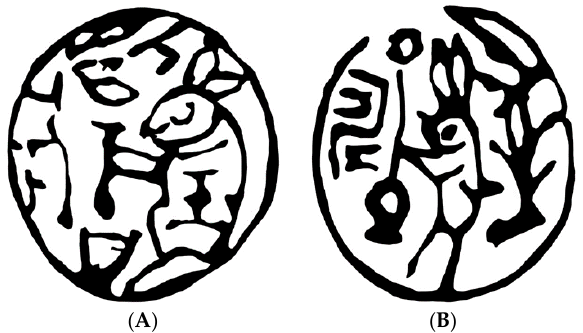
Figure 7. ( A ) A Song Yuan Huaya with a depiction of Jade rabbit-on-the moon. The period of the Song and Yuan Dynasties. Inventory number: 0703. Sketched by author. Picture source: Wen (1995), p. 201. The original collection: Bochuan, Huang. Zun Gu Zhai Ji Yin [ 《尊古齋集印》 ]. Book of impressions. ( B ) A Song Yuan Huaya with a depiction of Jade rabbit-on-the moon. The Yuan Dynasty. Inventory number: 0699. Sketched by author. Picture source: Wen (1995), p. 200.